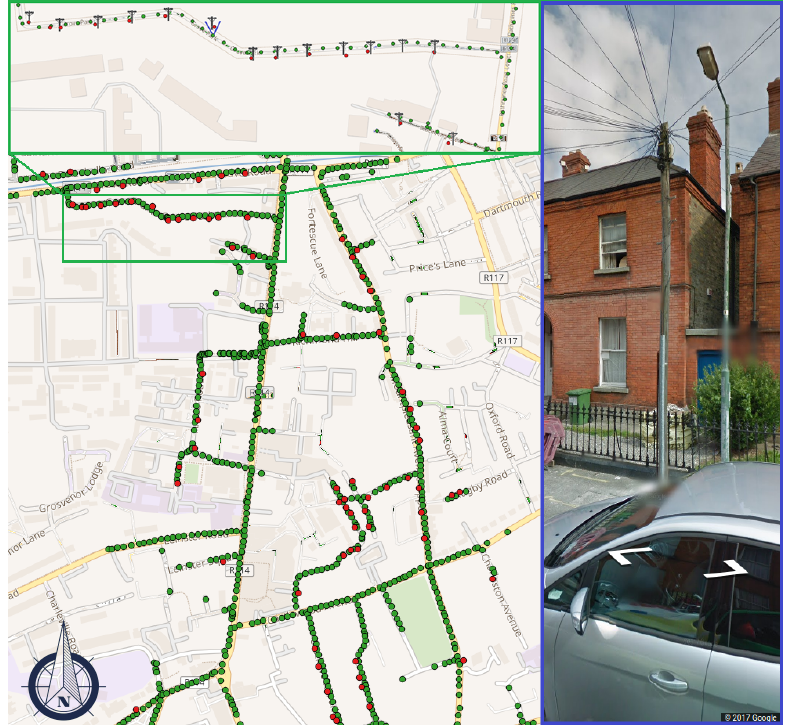
Figure 6. Map of telegraph poles detected in Dublin, Ireland. Green dots, red dots, and pole symbols (in zoom) are the GSV camera locations, detected and actual locations of objects, respectively. The image in blue is a GSV image of one of the poles with image position and geo-orientation set up based on our geotag